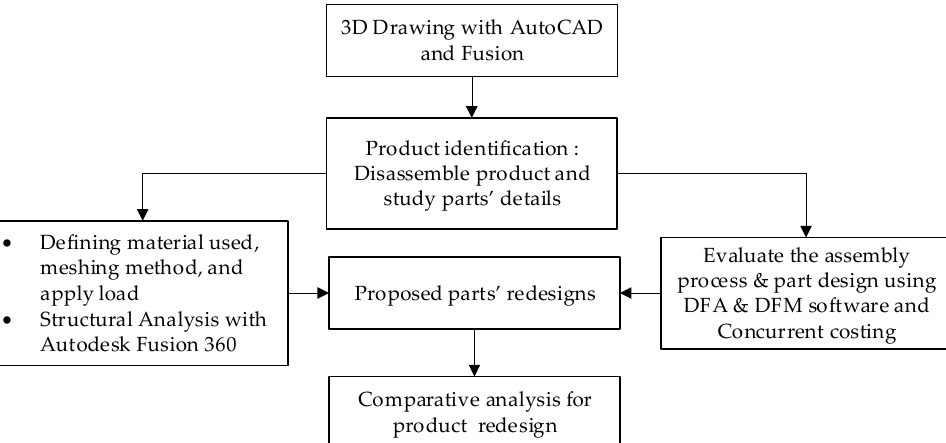
Figure 6. Workflow of the used software tools in DFMAR model.